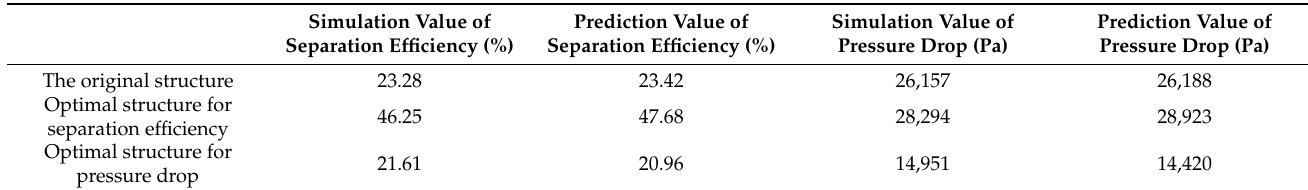
Figure 7. From left to right: comparison of the simulated response values of separation efficiency and the predicted values of the regression equation and correspondence between residuals and predicted values of the regression equation for ( a ) separation efficiency and ( b ) pressure drop. Table 9. Optimal combination of separation efficiency and pressure drop.